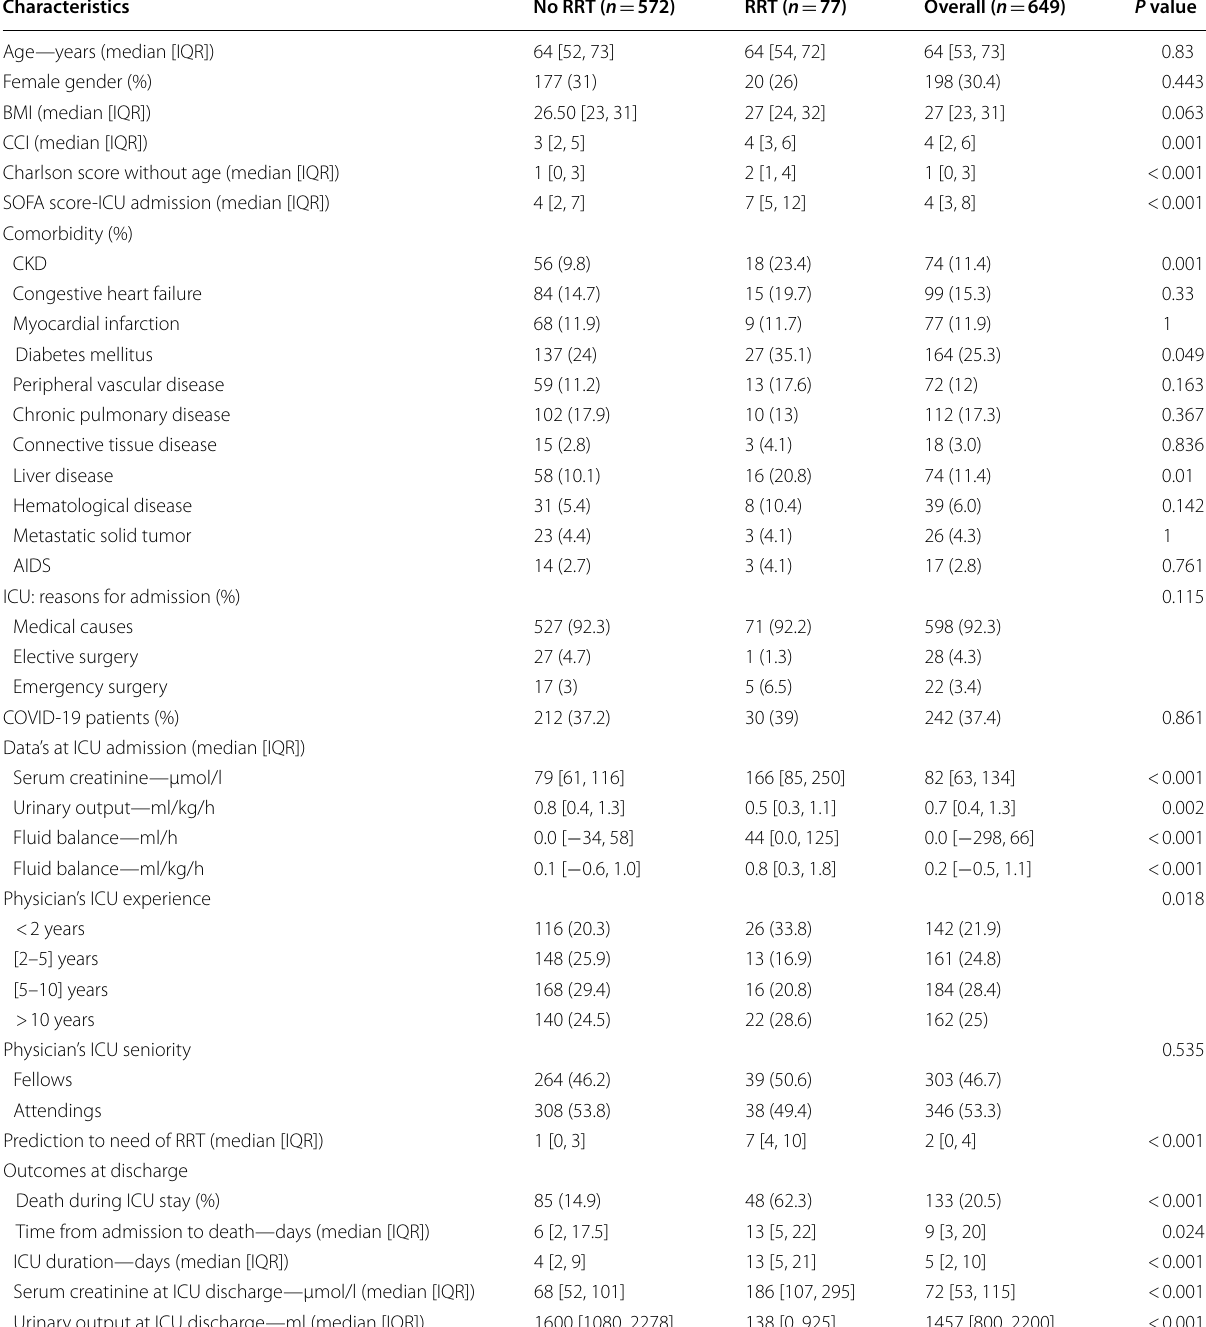
Table 1 Characteristics of patients, physician prediction and outcomes